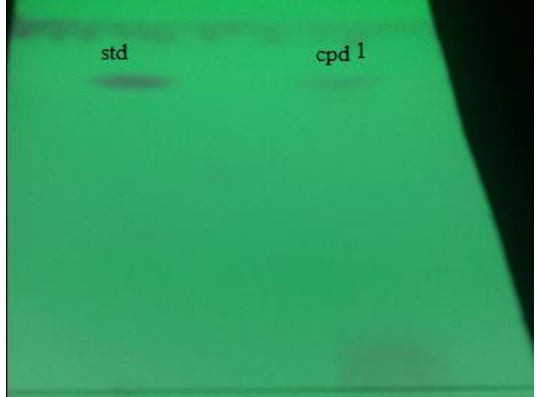
Figure 6. TLC chromatography for separated compound number (1) from ethyl acetate fraction and R.A standard using silica gel Gf254 as adsorbant and mobile phase